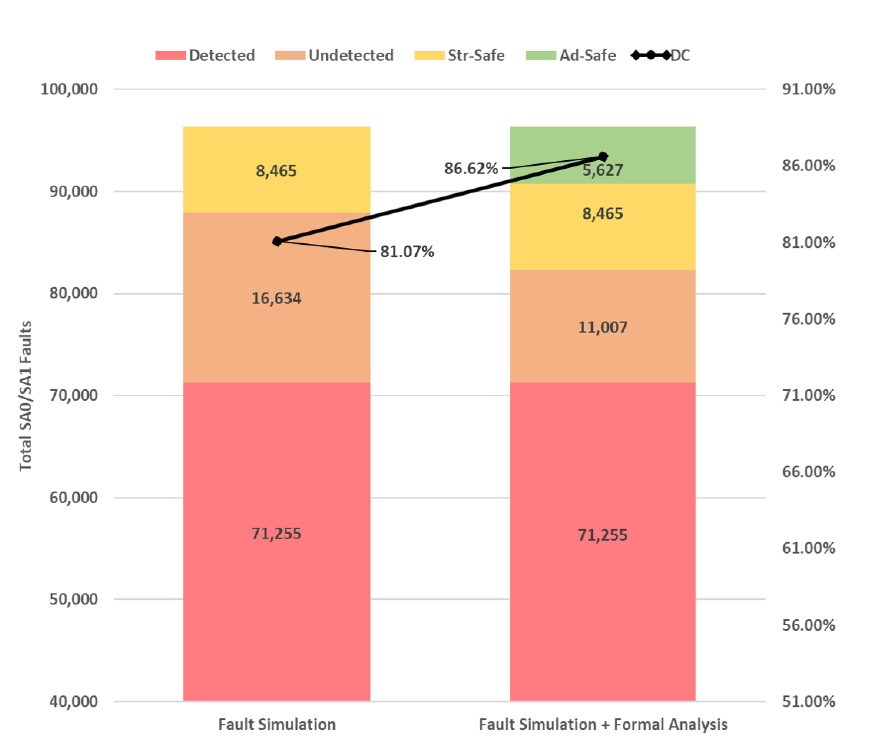
Figure 10. Combined results in CPU: uptrend in DC when fault simulation and formal analysis